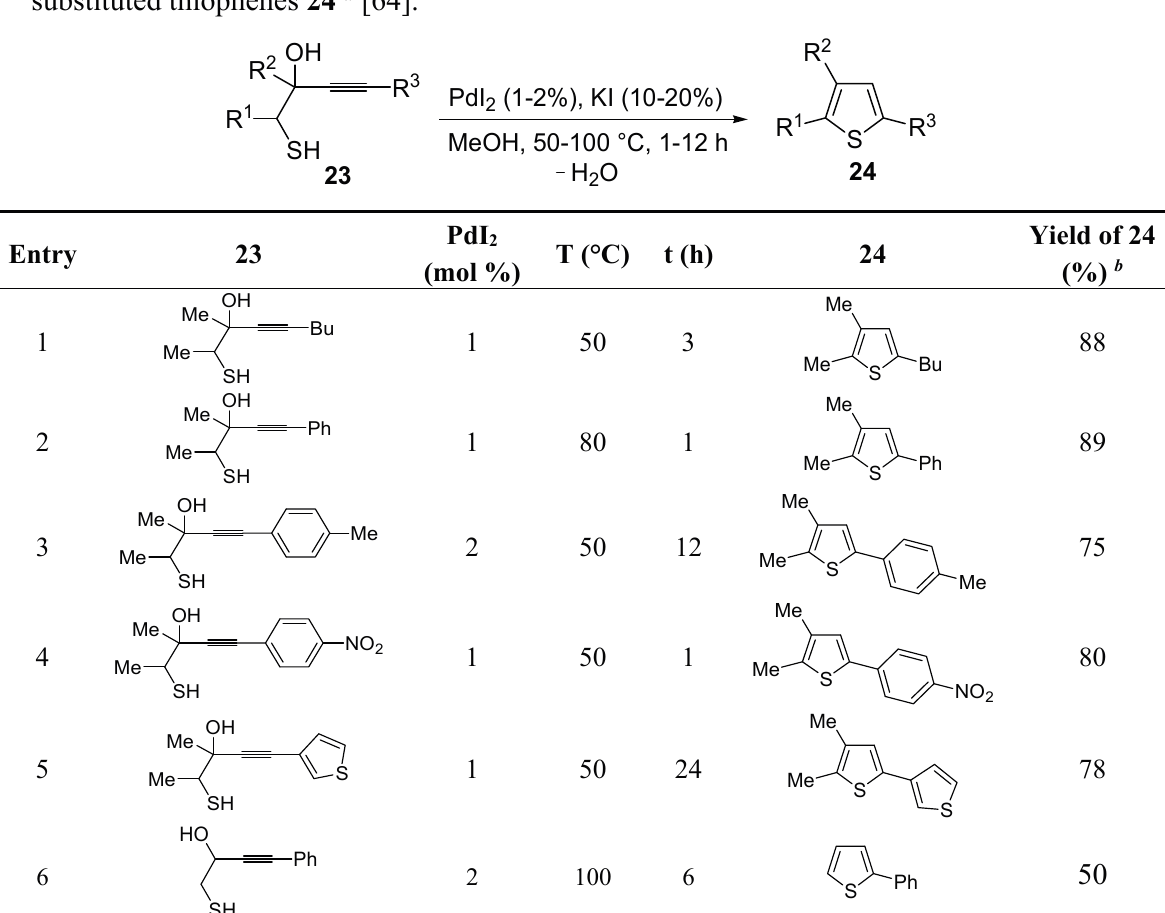
Table 2. PdI 2 /KI-catalyzed heterocyclodehydration of 1-mercapto-3-yn-2-ols 23 to substituted thiophenes 24 a